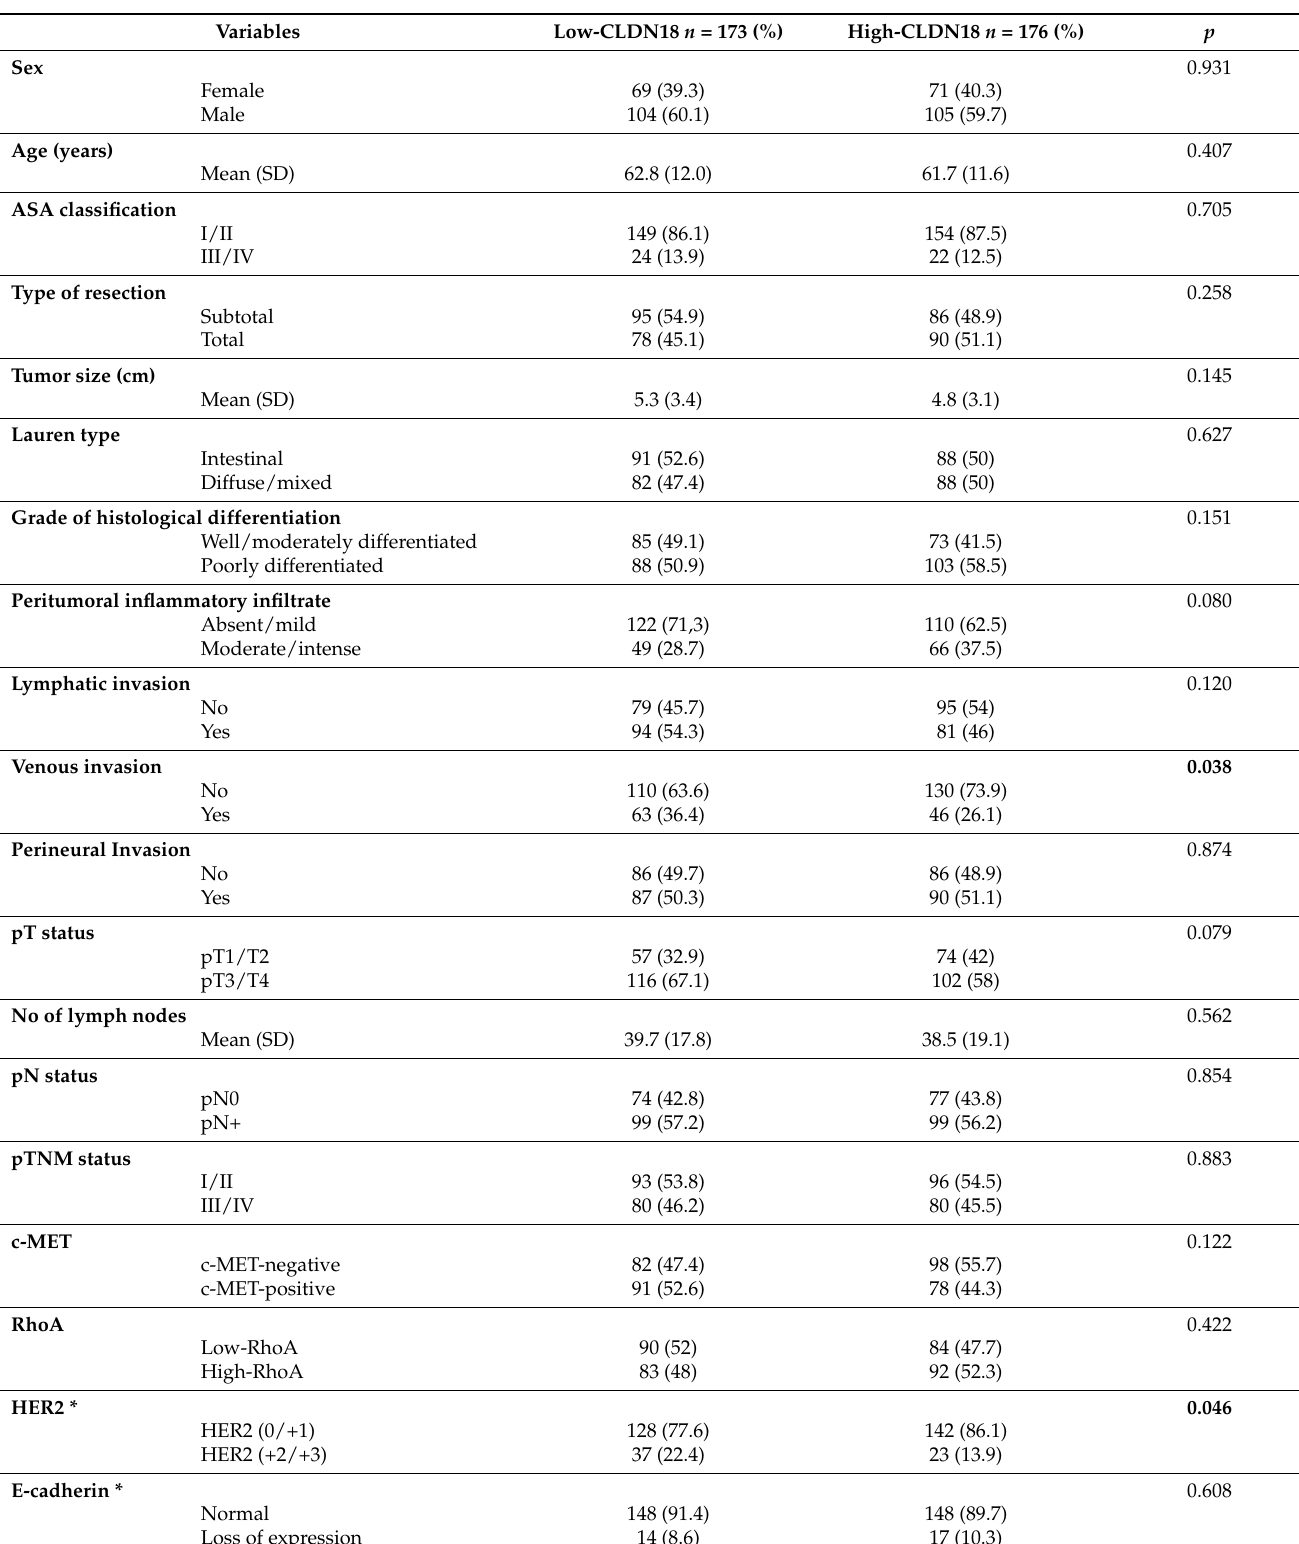
Table 3. Clinicopathological characteristics of gastric cancer patients according to the CLDN18